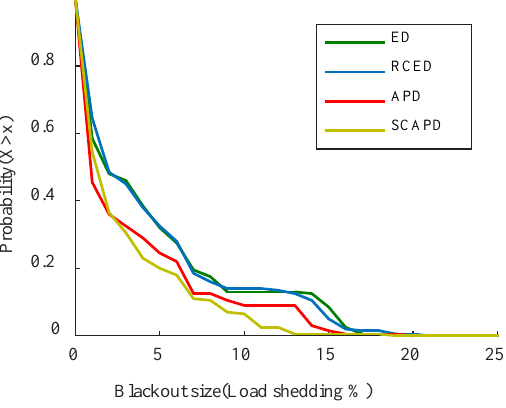
Figure 3. Probability distribution curves of blackout sizes for different models tested on the IEEE 30-bus system. Table 3. Simulation results of cascading failure blackouts for different models tested on the IEEE 30-bus system.